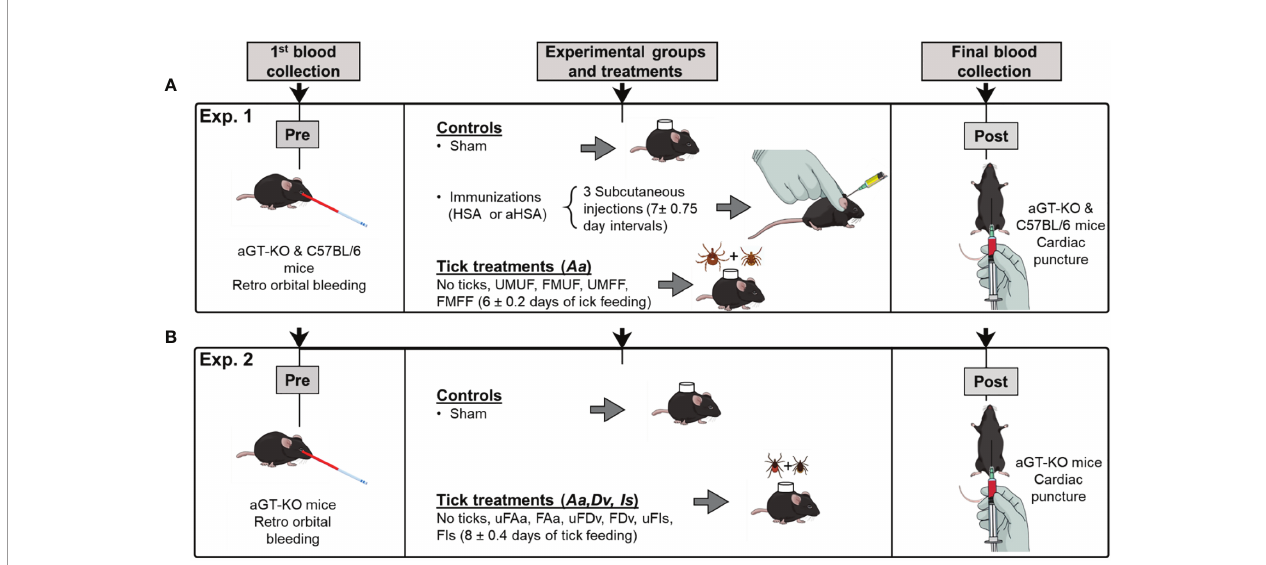
FIGURE 1 | A schematic diagram of the experimental design. (A) section outlines the treatments and structure for assessing RMA sensitization using pairs of Amblyomma americanum ticks (Experiment 1). The treatments were varied with partially fed and unfed (F,U) male and female (M,F), aGT-KO mice and C57BL/6 control mice. (B) experimental design for assessing comparisons between sensitization through bites of other ixodid tick species (Experiment 2), fed (F) and unfed (uF) ticks, Amblyomma americanum (Aa), Dermacentor variabilis (Dv), and Ixodes scapularis (Is). In all treatments involving ticks, male and female pairs of ticks were